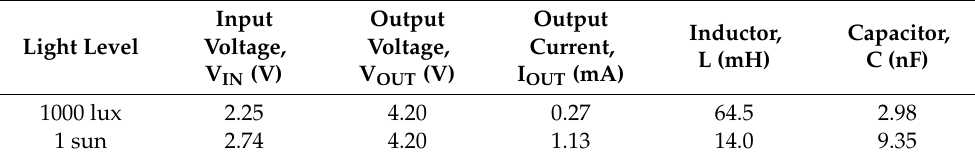
Table 3. Calculated boost converter parameters.